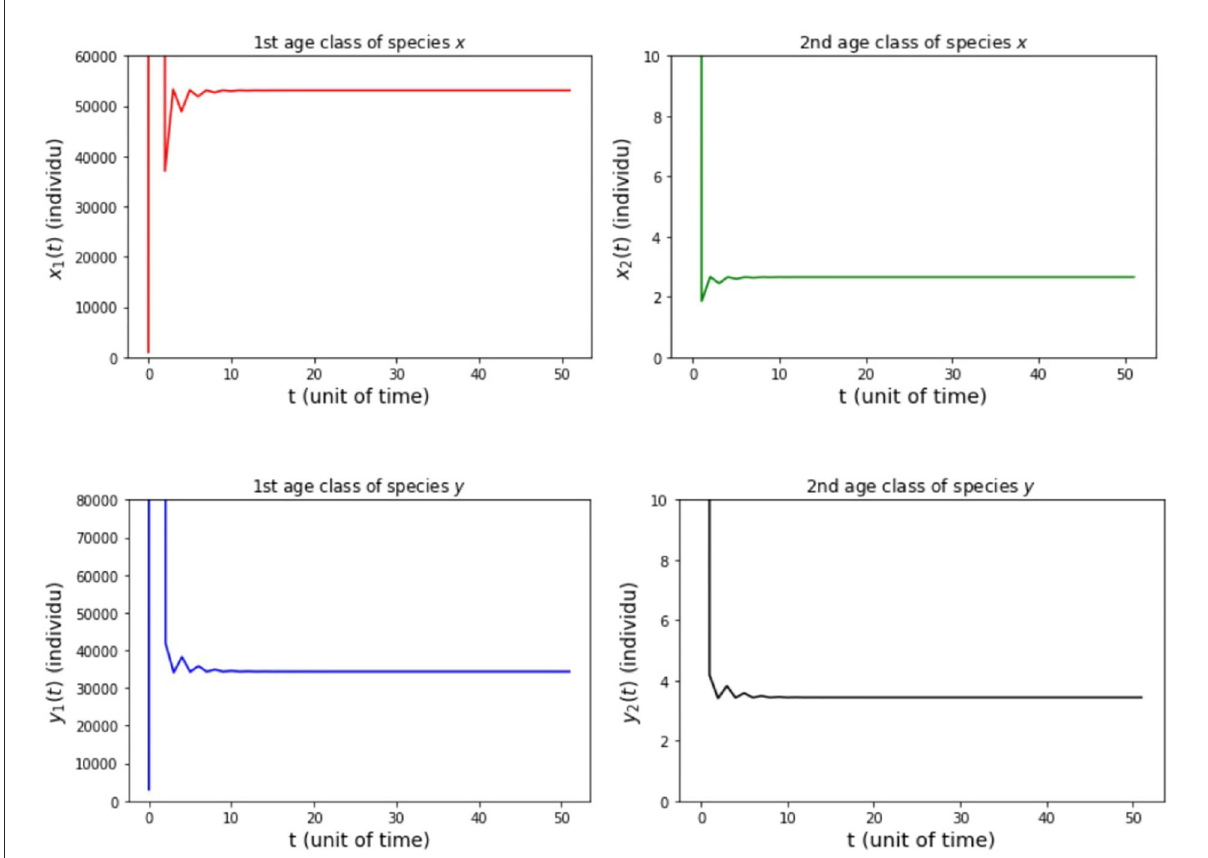
FIGURE8 Population growth of each age class from case (iv) Model